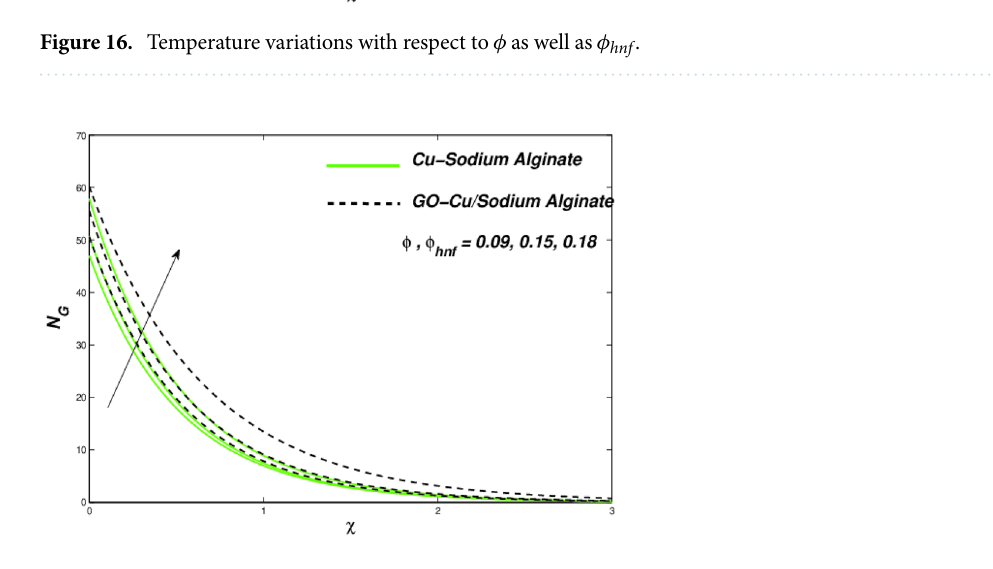
Figure 17. Entropy variations with respect to φ as well as φ hnf